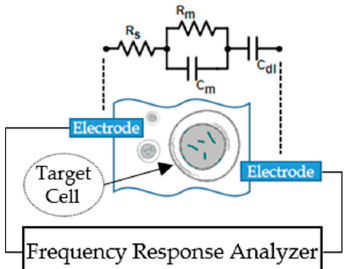
Figure 18. Two-channel prototype photograph.